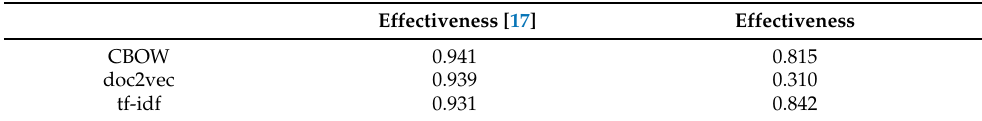
Table 7. Comparison of classification performance results for CBOW, doc2vec and tf-idf methods with the work